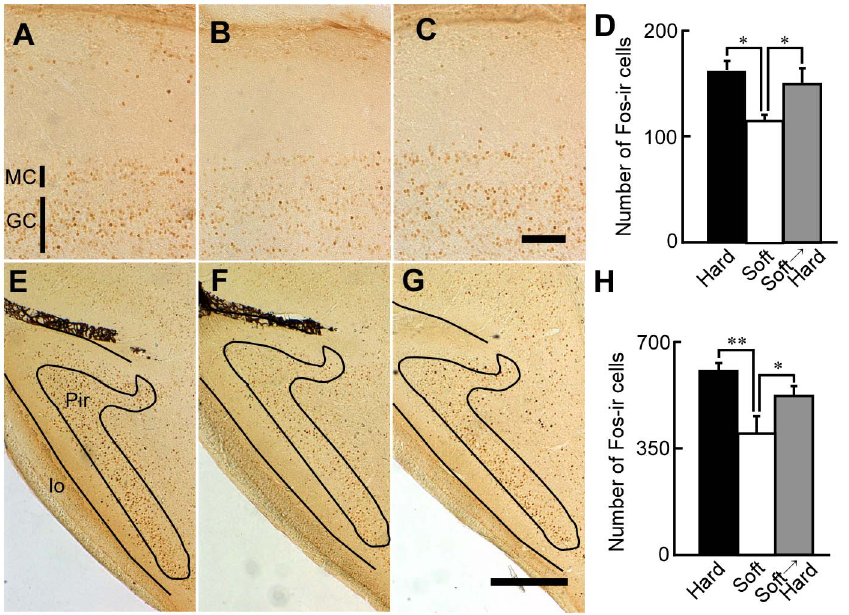
Figure 3. Fos-ir cells after exposure to urinary odor in the OB and Pir. Sagittal sections of the OB and Pir after exposure of mice fed only a hard diet (A and E), only a soft diet (B and F), or a hard diet for 3 months after a soft diet for 1 month (C and G) to urinary odor, respectively. Scale bar: 200 m m (C), 500 m m (G). D: The numbers of Fos-ir cells in the mitral cell layer in 500 m m thickness from Figure 108 of the mouse atlas (lateral 0.84 mm) of the OB to the lateral side of mice fed only the hard diet (black column; n=5), only the soft diet (white column; n=5), or the hard diet after the soft diet (gray column; n=5). H: The number of Fos-ir cells in 400 m m thickness from Figure 114 of the mouse atlas (lateral 1.56 mm) of the Pir of mice fed only the hard diet (black column; n=5), only the soft diet (white column; n=5), or the hard diet after the soft diet (gray column; n=5). *: p , 0.05; **: p , 0.005.